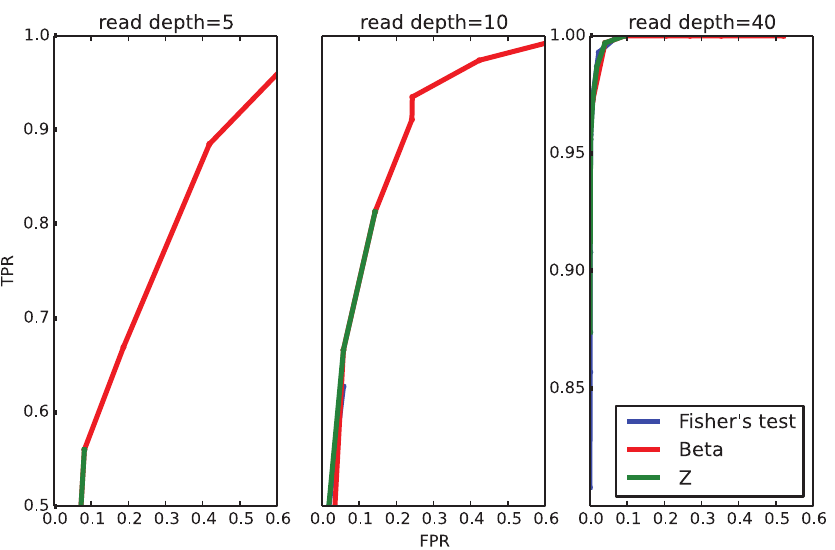
Figure 2. ROC curves for the three methods under comparison. Each point in the ROC curve is obtained by choosing a different threshold for calling differential methylation. For the Z score test and the Fisher’s test the p-values are: 10 { 1 ,5 | 10 { 2 ,2 | 10 { 2 ,10 { 2 ,5 | 10 { 3 ,2 | 10 { 3 ,10 { 3 . For the Beta distributions the threshold probabilities are: 0 : 5,0 : 6,0 : 7,0 : 8,0 : 9,0 : 95,0 : 99 . TPR means true positive rate; FPR means false positive rate.